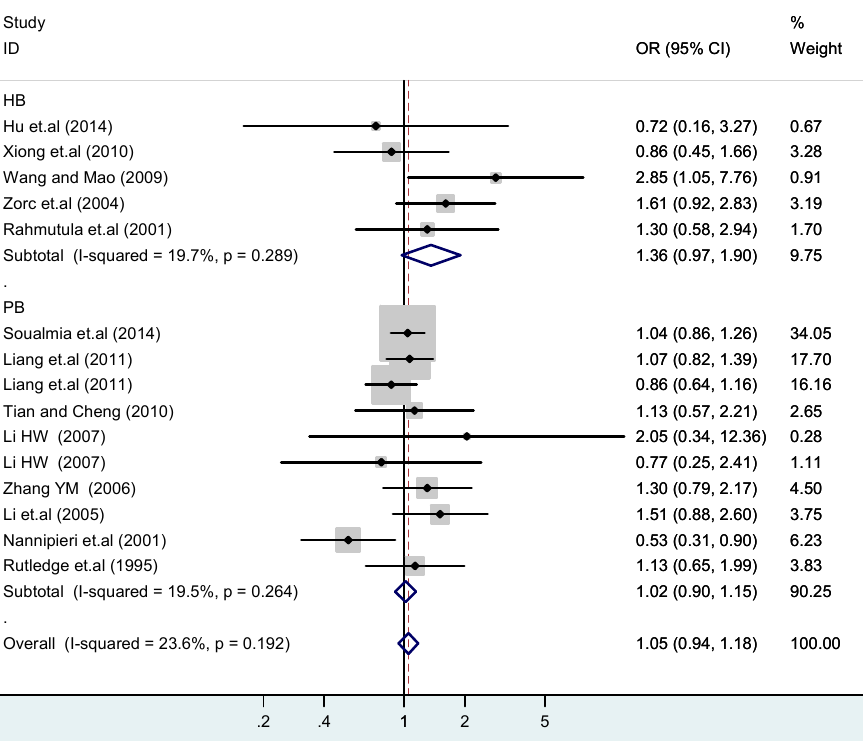
Figure 13. Ethnic subgroup analysis of T2238C recessive model CC vs. (TT + TC). Int. J. Environ. Res. Public Health 2016 , 13 , 458